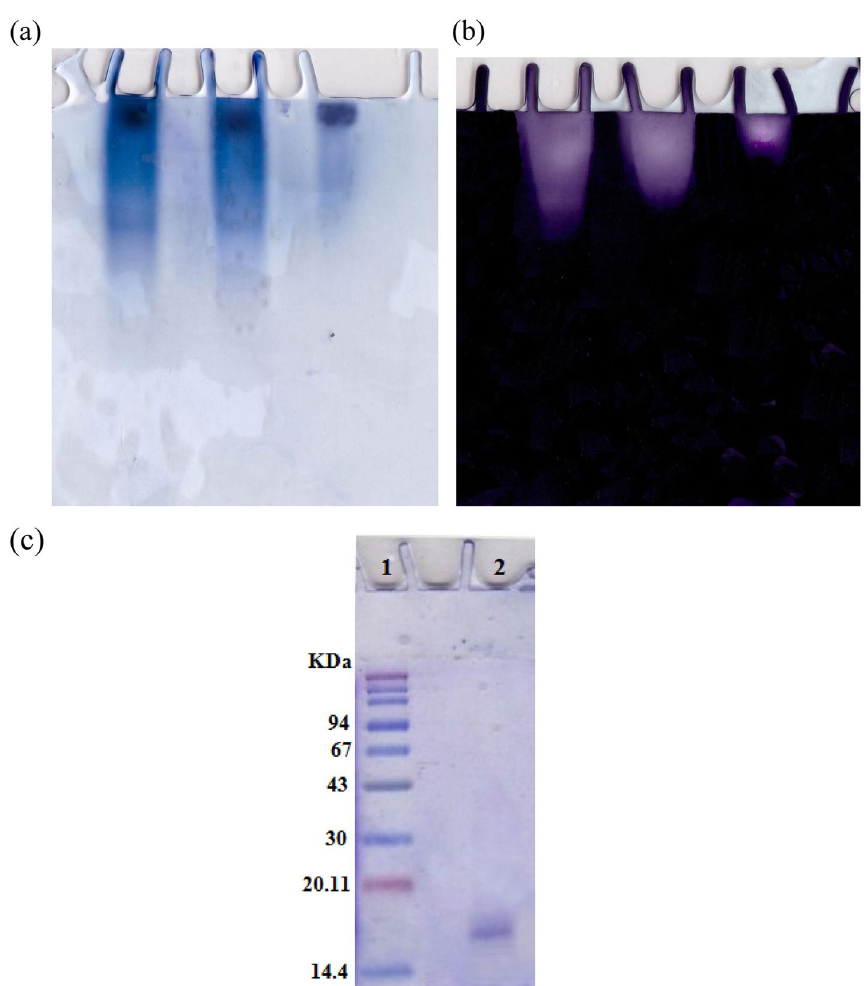
Fig. 3 a Electrophoretic analysis of superoxide dismutase (enzyme protein pattern) of the different purification steps on 7% native polyacrylamide gel: (1) crude venom, (2) DEAE‑cellulose fraction, and (3) Sephacryl S‑300 purified fraction of BVSOD. b Electrophoretic analysis of superoxide dismutase (enzyme activity pattern) of the different purification steps on 7% native polyacrylamide gel: (1) crude venom, (2) DEAE‑cellulose fraction, and (3) Sephacryl S‑300 purified fraction of BVSOD. c Subunit molecular weight determination by electrophoretic analysis of purified BVSOD on 12% SDS–polyacrylamide gel: (1) molecular weight marker proteins and (2) purified superoxide